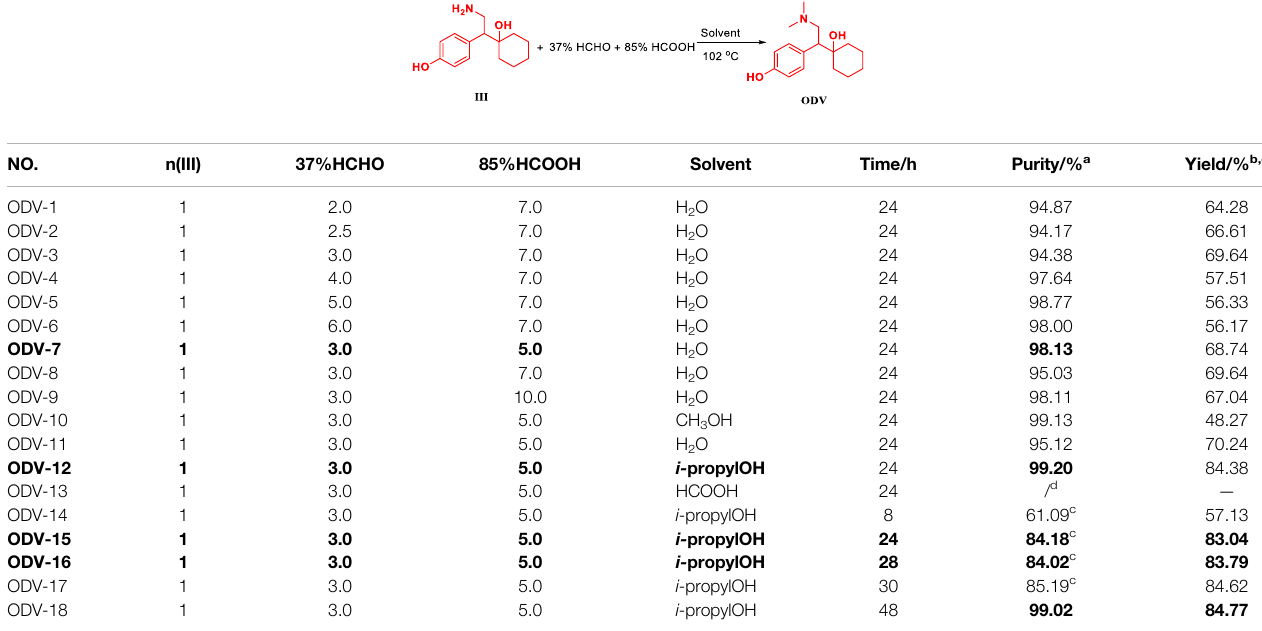
TABLE 4 | Condition optimization of